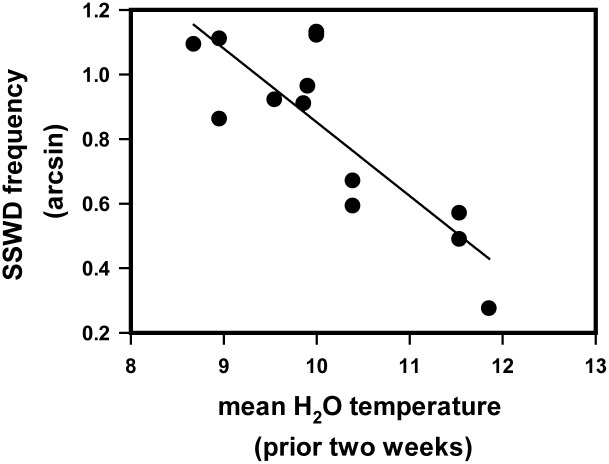
Log-linear regression between water temperature averaged over the previous two weeks of the sample date and the frequency (arcsin-transformed) of SSWD on the sample date.